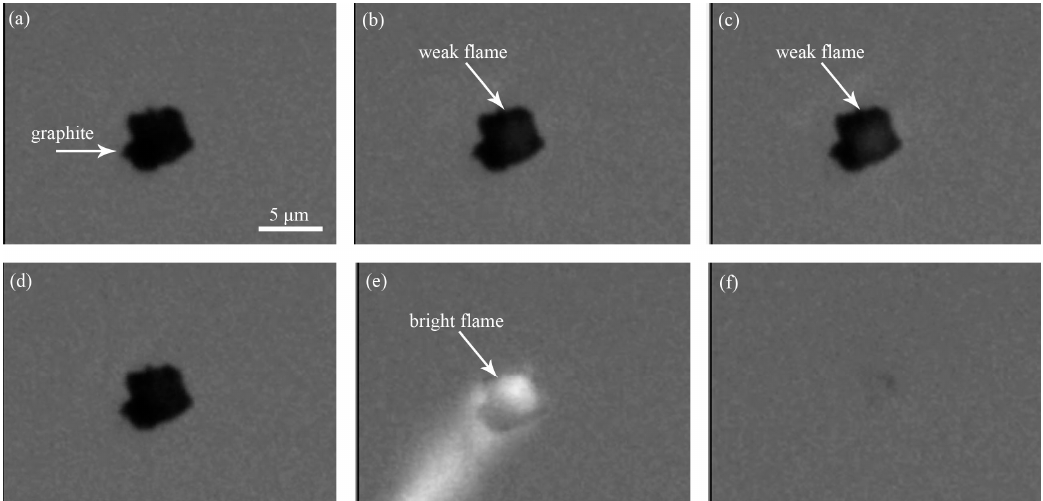
Figure 6. A burning sequence and flame structure of an individual micron-sized graphite particle, ( a ) 0 ms; ( b ) 6 ms; ( c ) 30 ms; ( d ) 36 ms; ( e ) 42 ms; ( f ) 48 ms.